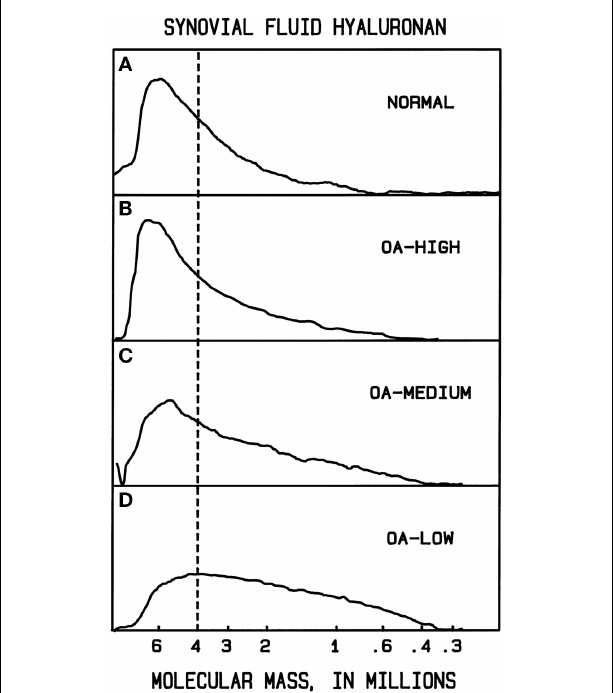
FIGURE 1 | Example molecular mass distributions of human synovial fluid (SF) HA determined by agarose gel electrophoresis . From top to bottom: (A) normal human SF obtained from young healthy volunteers. (B–D) Representative osteoarthritis (OA) patient SF. The dashed vertical line corresponds to the migration position of 4000kDa HA. The fraction of HA having slower electrophoretic migration, and thus higher M than 4000kDa, is a measure of the high M HA content. In normal human SF, the portion of HA with M >4000kDa averaged 61%. OA patients varied in the extent of HA degradation. The OA-HIGH profile, similar to that seen in normal SF and representative of OA samples with more than 60% of HA having M >4000kDa, was found for 26% of patients. The OA-MEDIUM profile, representative of OA samples with approximately 41–60% of HA having M >4000kDa, was found for 41% of patients. The OA-LOW profile, representative of OA samples with <40% of HA having M >4000kDa, was found for 33% of patients. From Lee